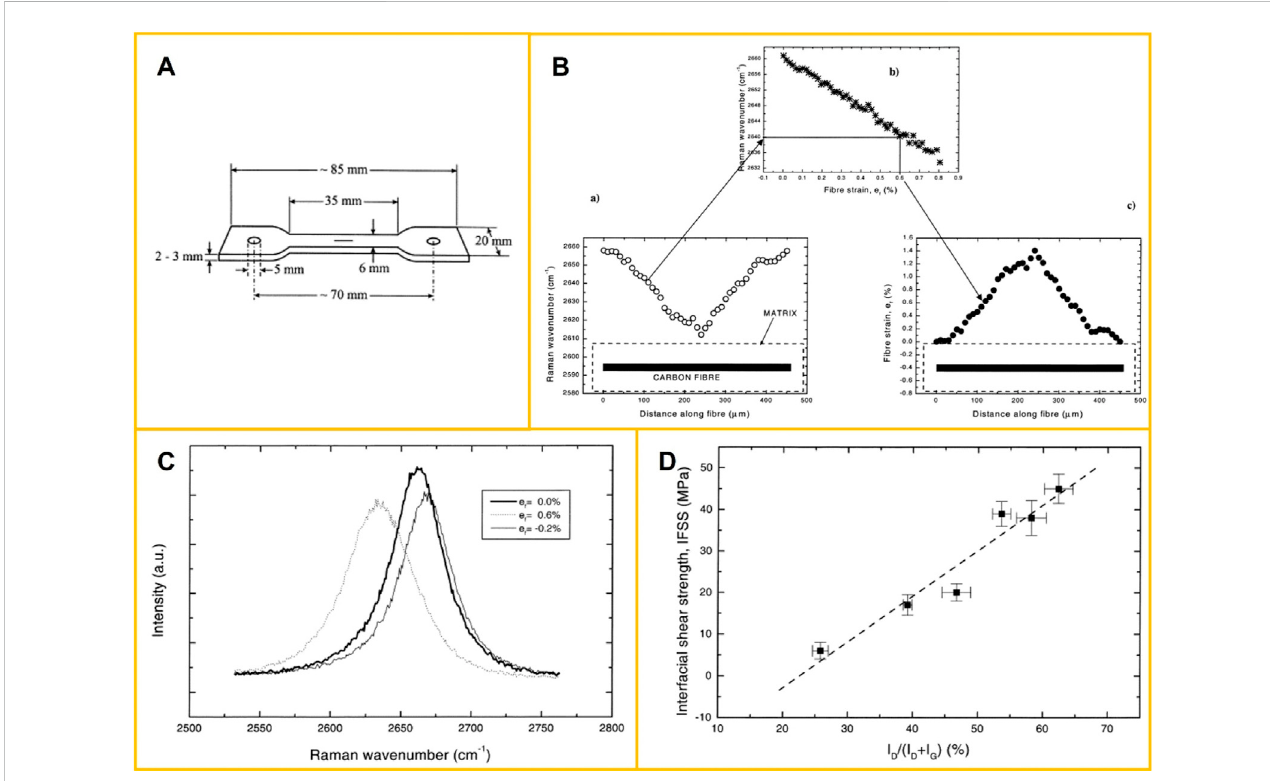
FIGURE 13 (A) Scheme and dimensions of the dumbbell single- fi bre-epoxy specimens used to characterize the interface by use of Raman spectroscopy. Reprinted withpermissionfrom(Montes-MoránandYoung,2002).Copyright2002ElsevierScienceB.V. (B) Basicstepsdescribingtheexperimentalprocedurefollowed during Raman spectroscopy studies of interfaces in composites: (a) Raman spectra is taken along the fi ber and the maximum of a Raman band is plotted vs. distance from fi ber ends; (b) the maximum of the Raman band is transformed to strain using the appropriate calibration curve; (c) the strain distribution along the fi ber is fi nally obtained. Reprintedwith permission from (Montes-Morán and Young, 2002). Copyright 2002 Elsevier Science B.V. (C) The shift of the G ’ (~2,660 cm − 1 ) Raman band peak on the application of tensile strain for the P100 fi ber. Reprinted with permission from (Montes-Morán and Young, 2002). Copyright 2002 Elsevier Science B.V. (D) Variation of the interfacial shear strength, IFSS, of the different fi ber-matrix systems with the parameter of structural order